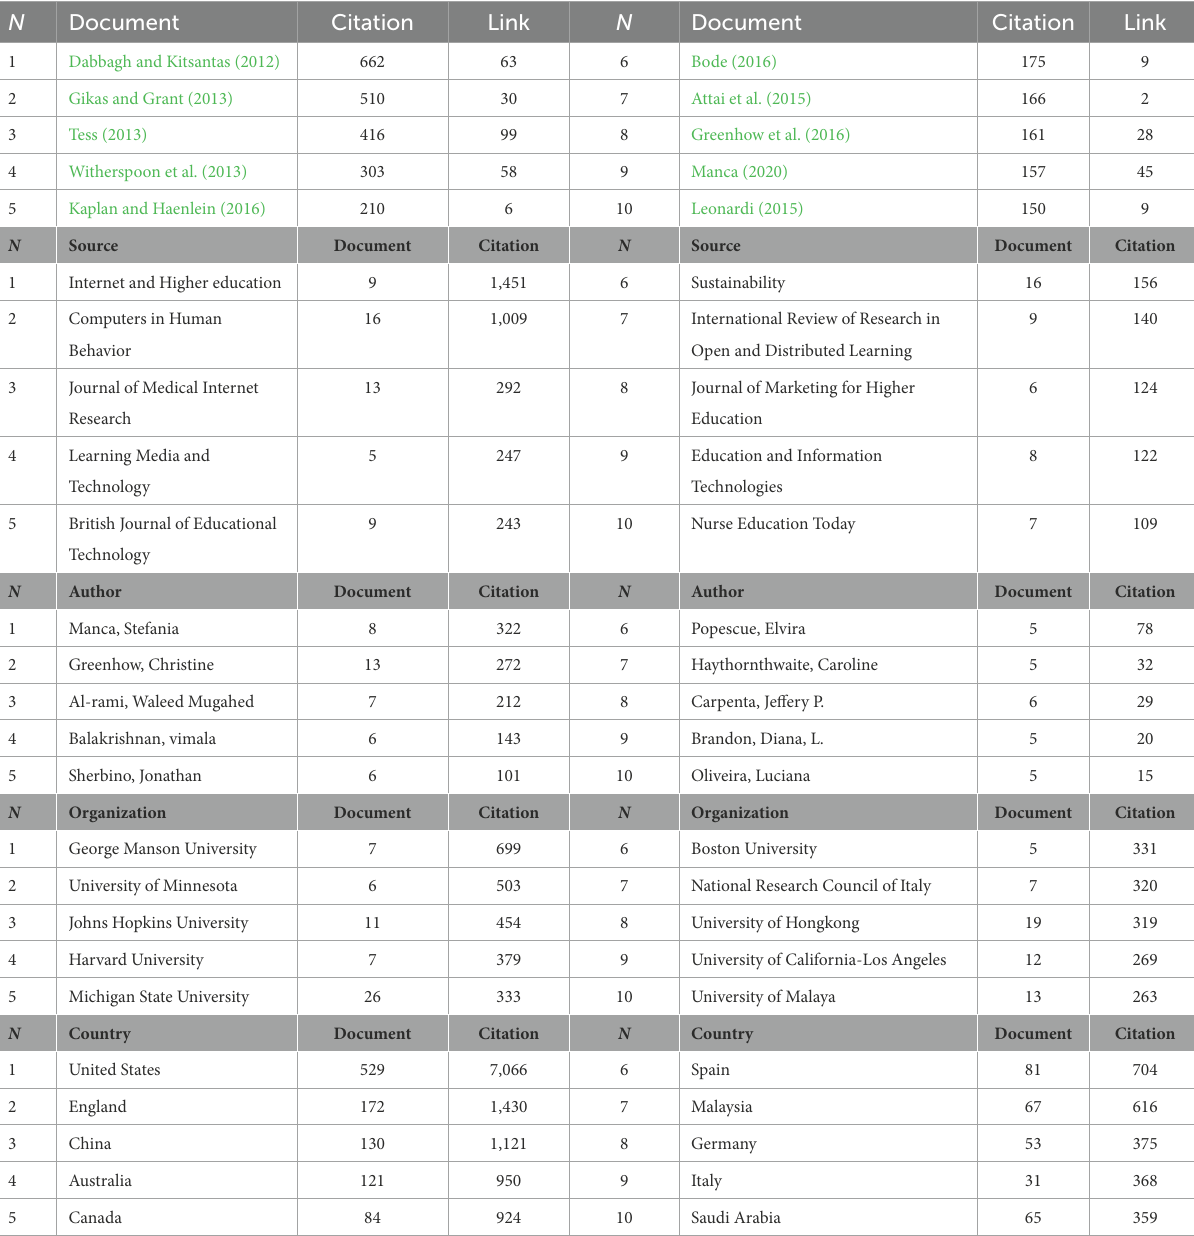
TABLE 5 Top 10 documents, sources, authors, organizations, and countries based on